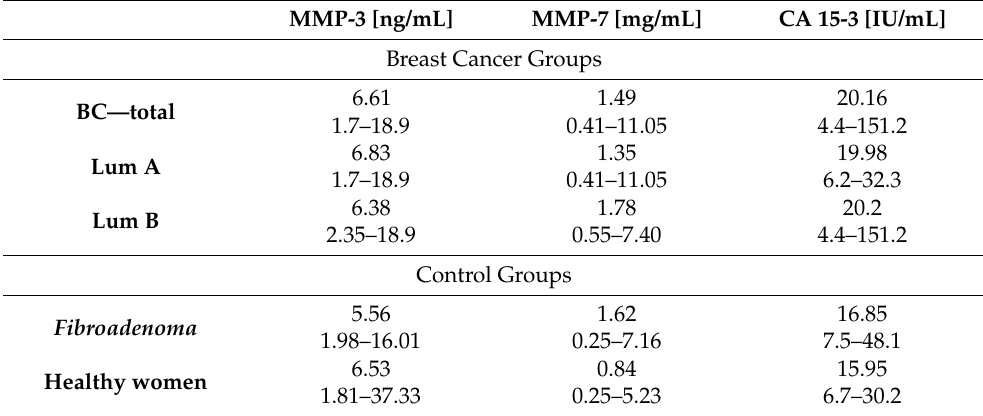
Table 2. Plasma concentrations (median and minimum-maximum range) of studied parame- ters: MMP-3, MMP-7 and comparative marker CA 15-3 in BC patients, fibroadenoma subjects and healthy